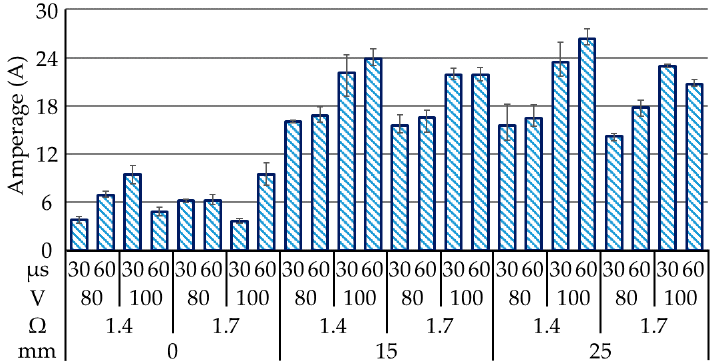
Figure 6. Measurements of discharge current in all 24 tests.